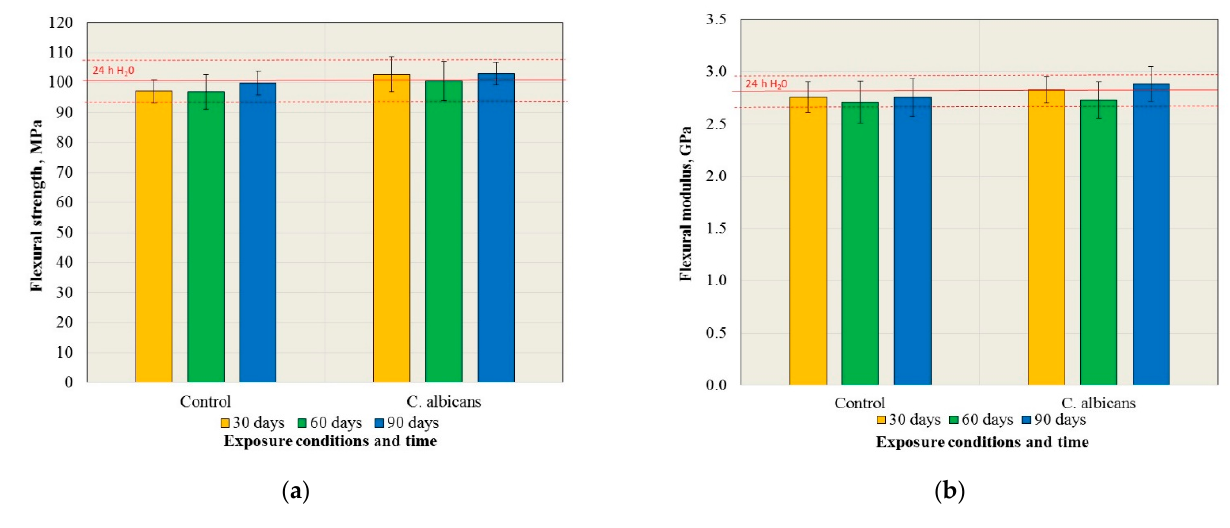
Figure 2. The values of the mean flexural strength ( a ) and flexural modulus ( b ) with the standard deviations after exposure to the control medium and the C. albicans suspension.